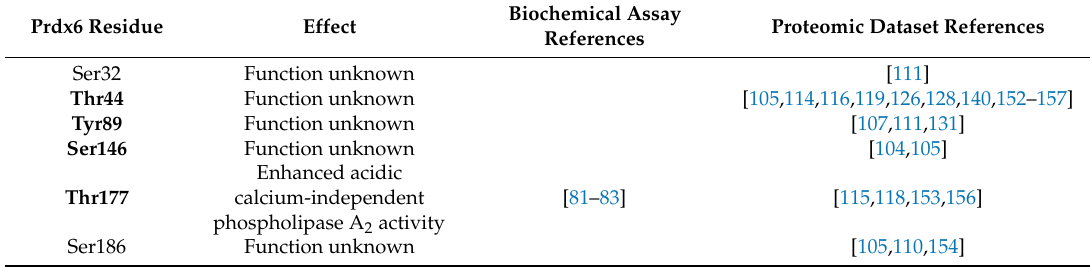
Table 6. Phosphorylation of Prdx6 can increase calcium-independent phospholipase A 2 activity to coordinate cell signaling. Phosphorylation sites that correspond to human Prdx6 in biochemical assays and proteomic studies are referenced are indicated. Phosphorylation sites that have been identified in proteomic screens in cancer models are in